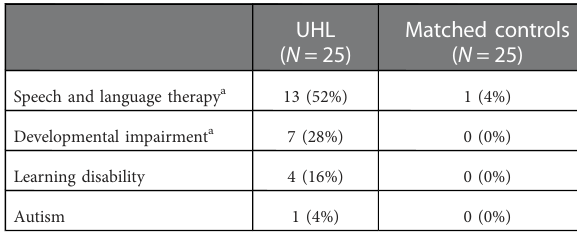
TABLE 3 Behavioural outcomes recorded to